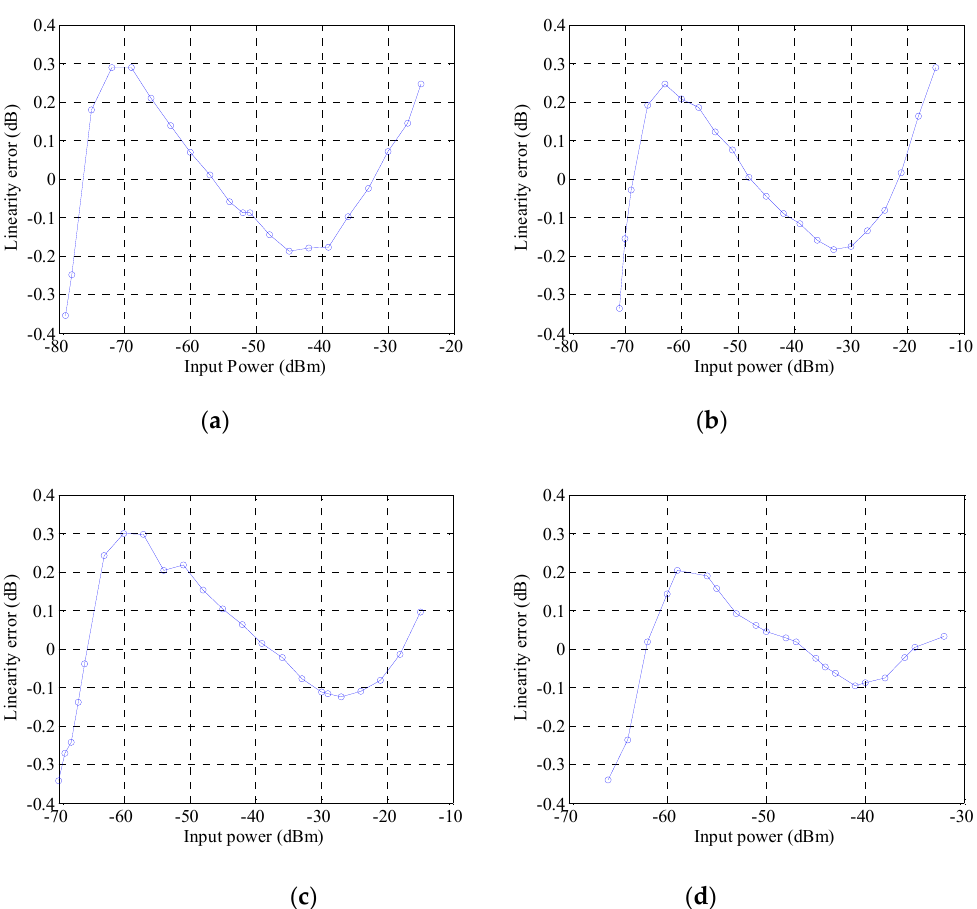
Figure 14. Linearity error for the full dynamic range: ( a ) L-band; ( b ) C-band; ( c ) X-band; ( d ) Ka-band.